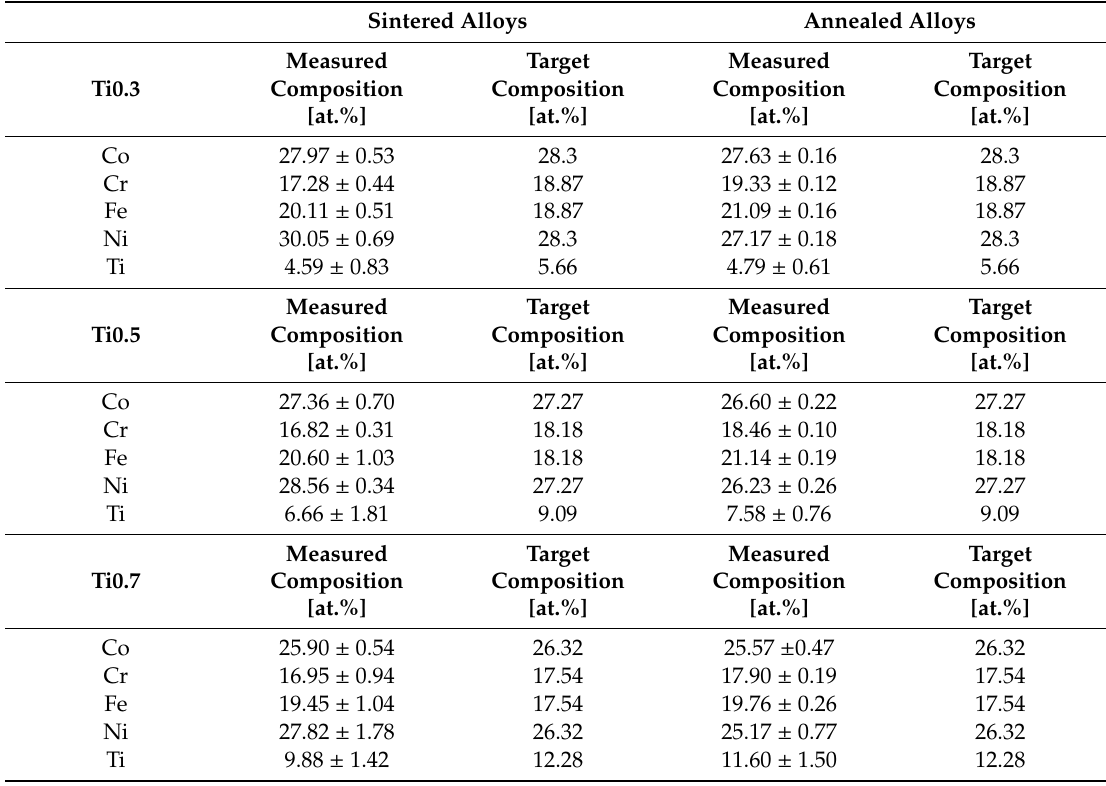
Table 4. Chemical compositions of the respective HEA FCC matrix obtained by EDS analysis of materials in as-sintered and annealed